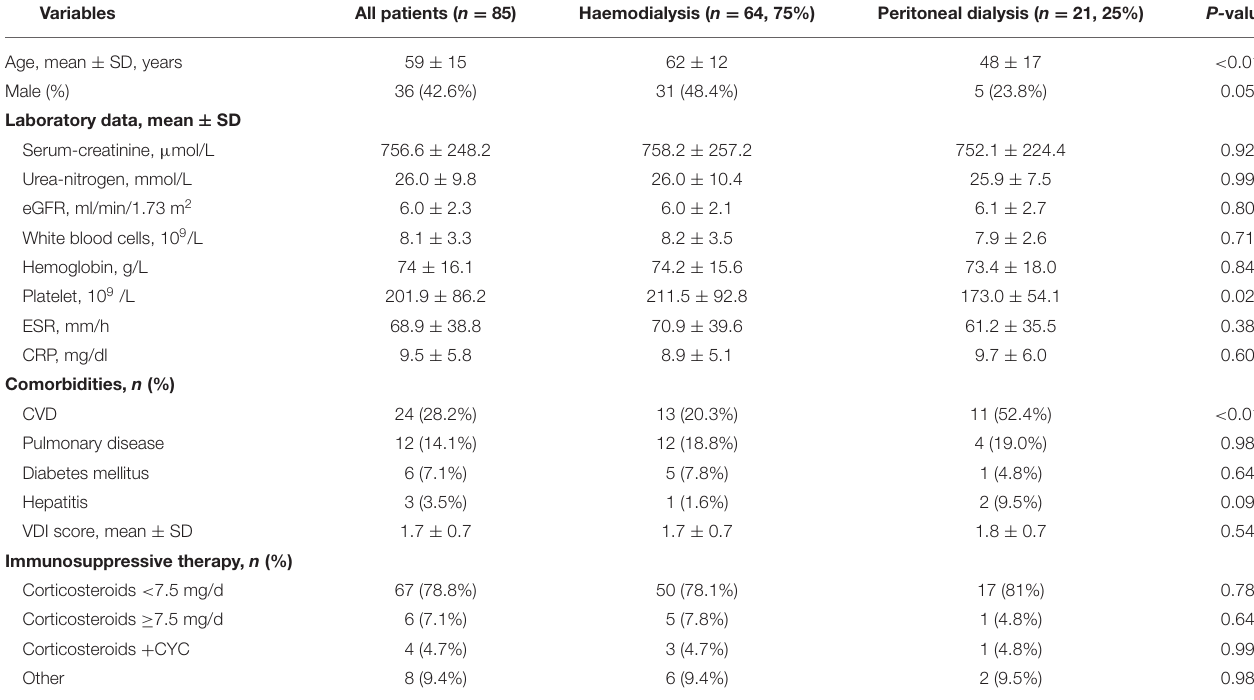
TABLE 1 | Baseline characteristics of patients with AAV-ESRD at start of dialysis. Variables